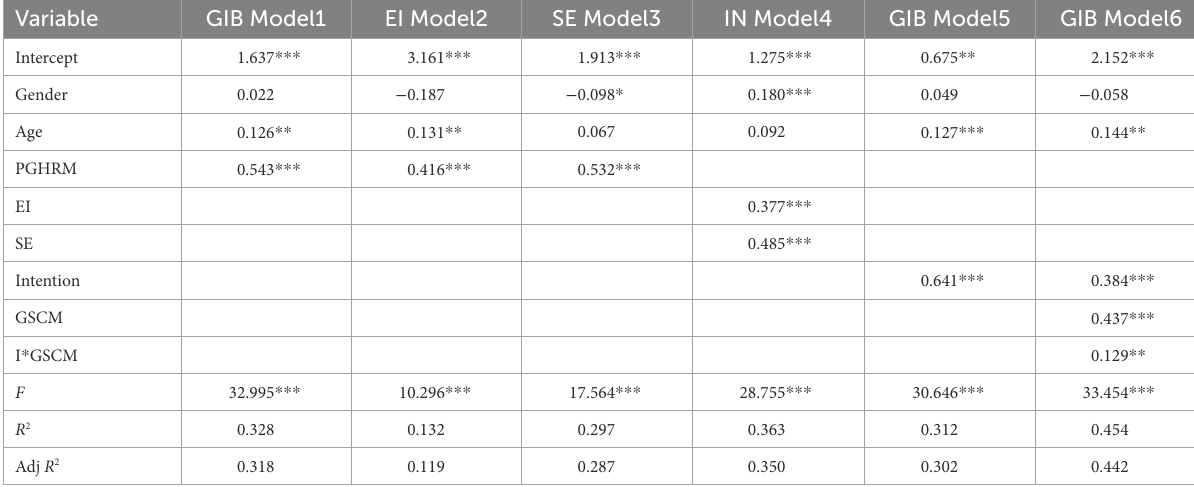
TABLE 4 Regression analysis results.